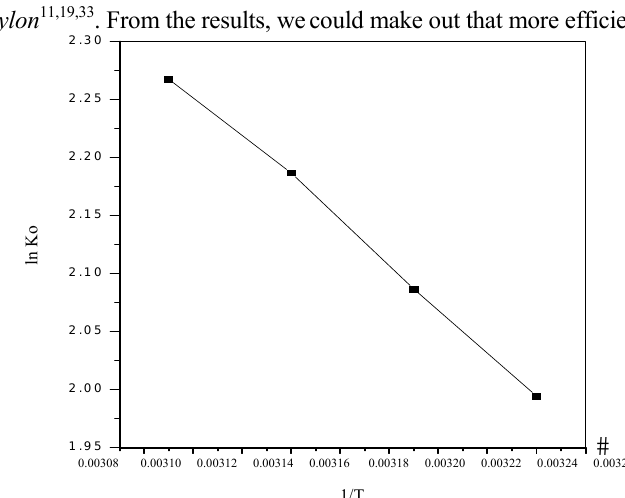
Figure 7. Vant H offs plot for the adsorption of copper ion by CBC [Cu]=30 mg/L; Adsorbent dose=25 mg/50 mL; Contect time =60